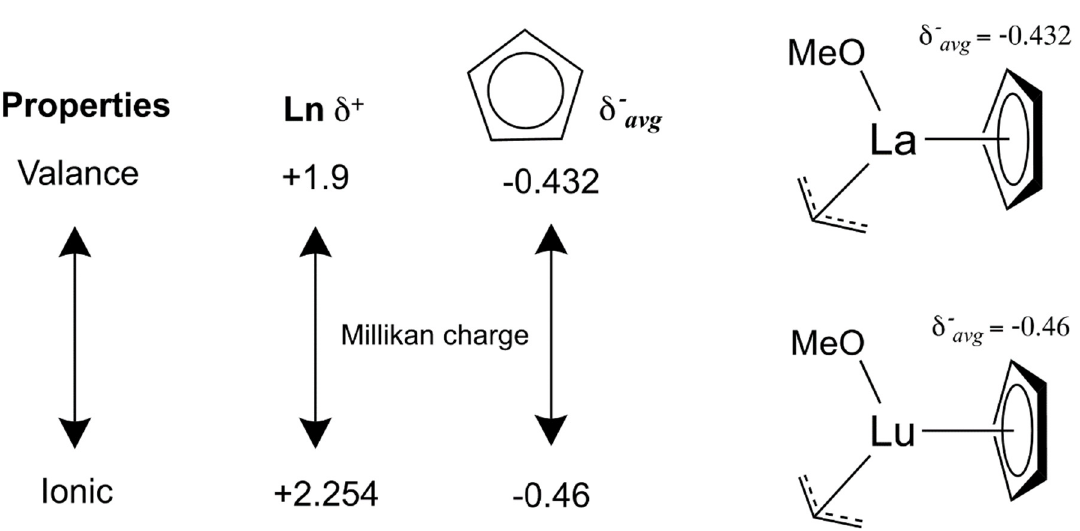
Figure 5. Summary of the covalency and ionicity property of the chelating bonds of Lanthanide (III) (III) complexes.